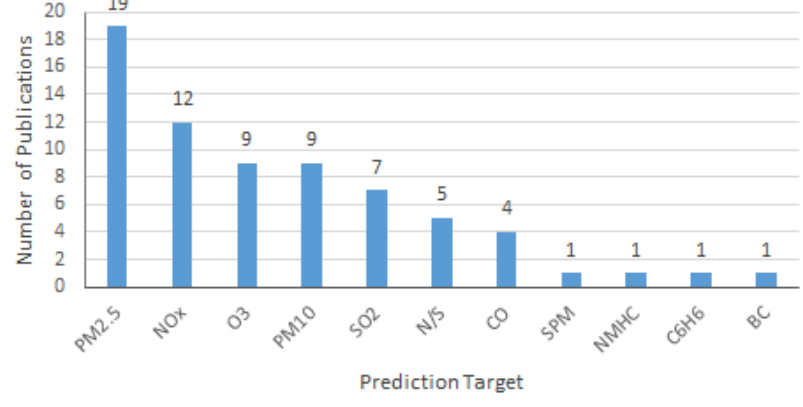
Figure 7. Pollutants as a prediction